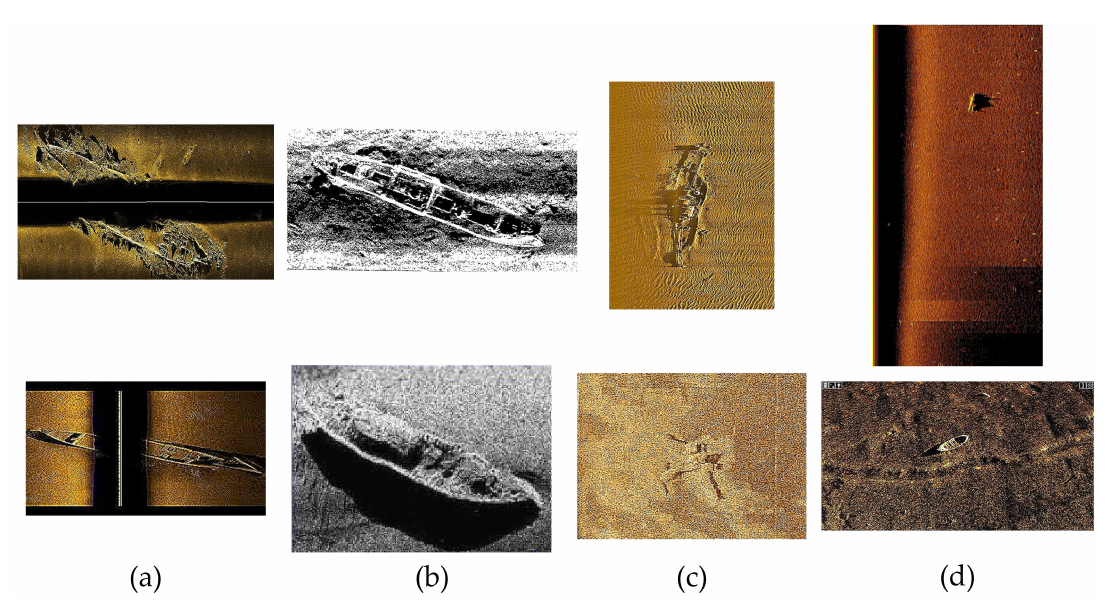
Figure 9. Examples in SCTD: ( a ) fractured; ( b ) low quality; ( c ) eroded; ( d ) small.